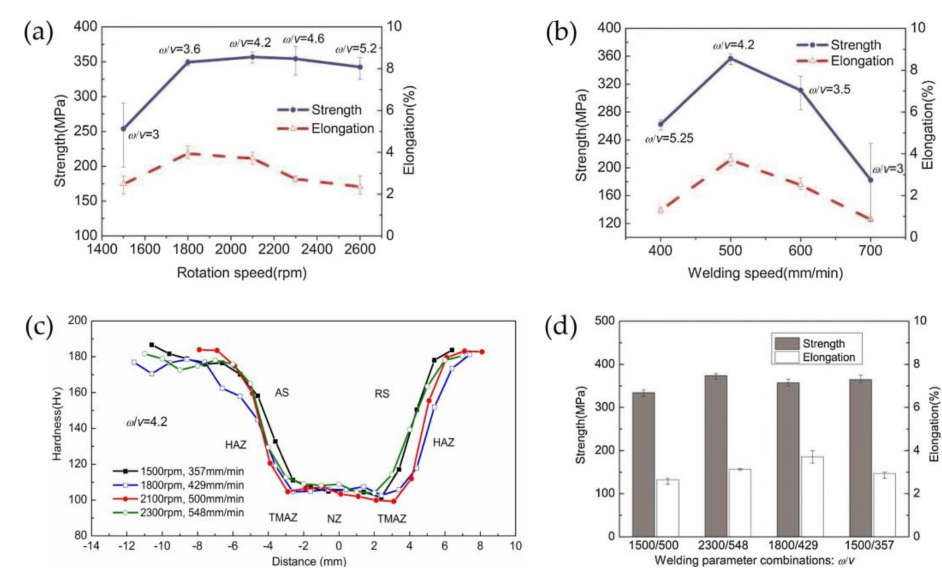
Figure 14. The effect of welding parameters on mechanical properties of friction stir welding [140]. ( a ) The effect of rotation speed on mechanical properties of joints; ( b ) the effect of welding speed on mechanical properties of joints; ( c ) micro-hardness profiles for cross-sections of joints under different combinations of rotation speed and welding speed ( ω /v = 4.2); ( d ) the effect of welding parameters on tensile strength and engineering elongation of the